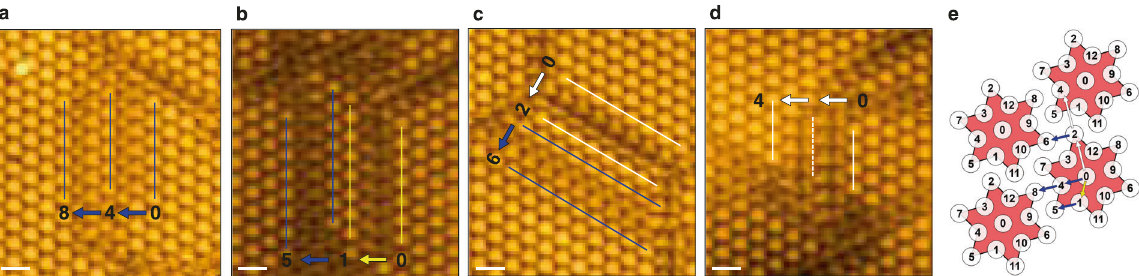
Fig. 2 Narrow domains between stable domain walls. a A single-row domain with two DW-4 structures instead of DW-8 (scale bar = 2 nm). b A double-row domain with DW-1 and DW-4 structures instead of DW-5. c A double-row domain with DW-2 and DW-4 structures instead of DW-6. d Direct connected two DW-2 structures without a domain. e Corresponding phase shift vectors on the David-star